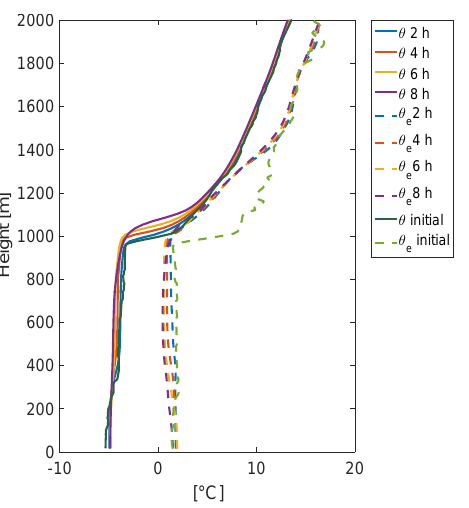
Figure 12. θ (left) and θ e (right) profiles of the initial condi- tions (dark green and green) and domain-averaged profiles after 2h (blue), 4h (orange), 6h (yellow), and 8h (purple) after the start of the SensIce simulation with an ice crystal concentration 10L − 1 .